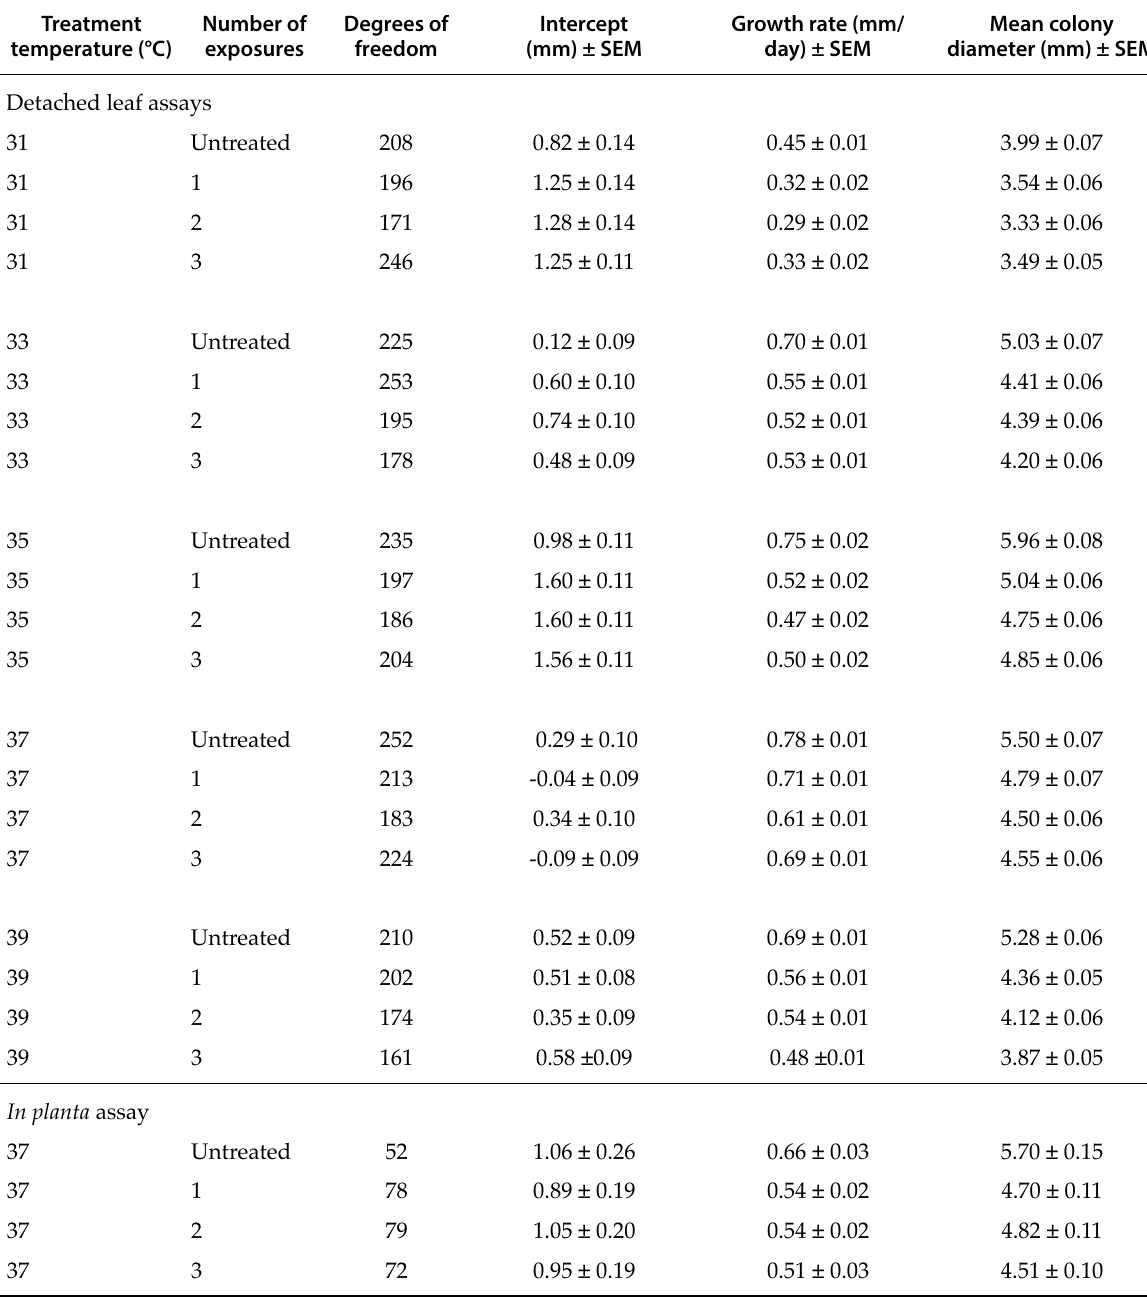
Table 1. Results of the linear regression of Erysiphe necator colony growth and the mean colony diameter from detached leaf assays and the in planta